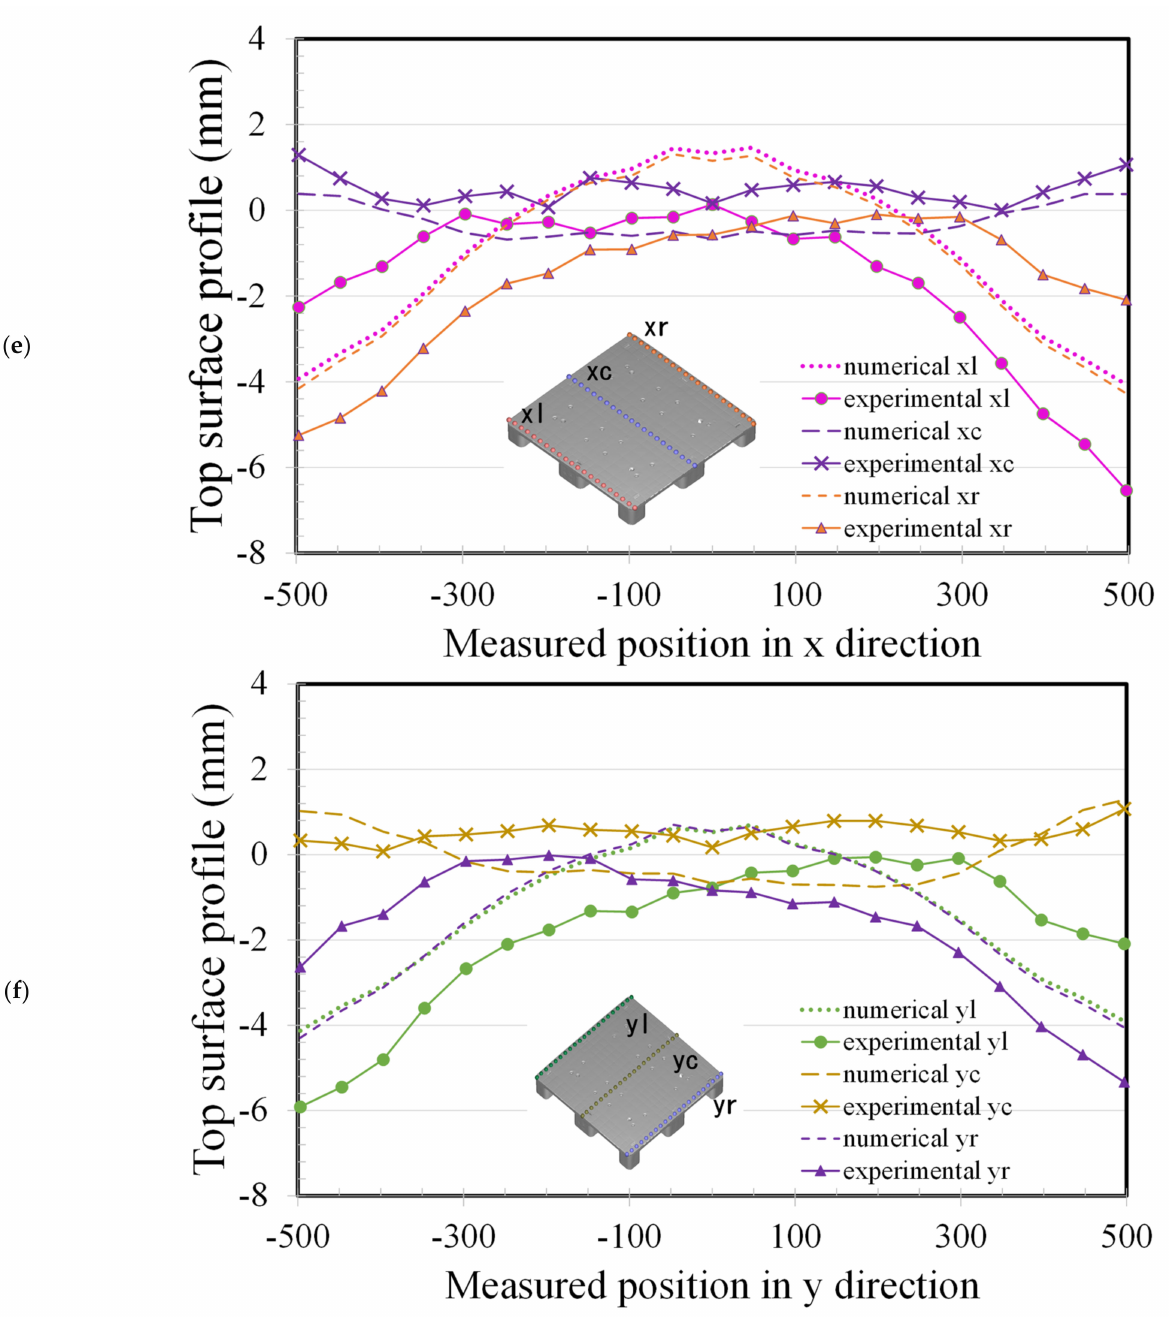
Figure 4. Comparisons of the numerical and experimental flatness under the pre-set sequential valve gate-opening scheme (20 ◦ C cooling channel). ( a ) Isometric view of ATOS-measured top flatness of pallet; ( b ) Isometric view of numerical top flatness of pallet; ( c ) isometric view of ATOS-measured bottom flatness of pallet; ( d ) Isometric view of numerical bottom flatness of pallet; ( e ) x-axial top surface profiles; ( f ) y-axial top surface